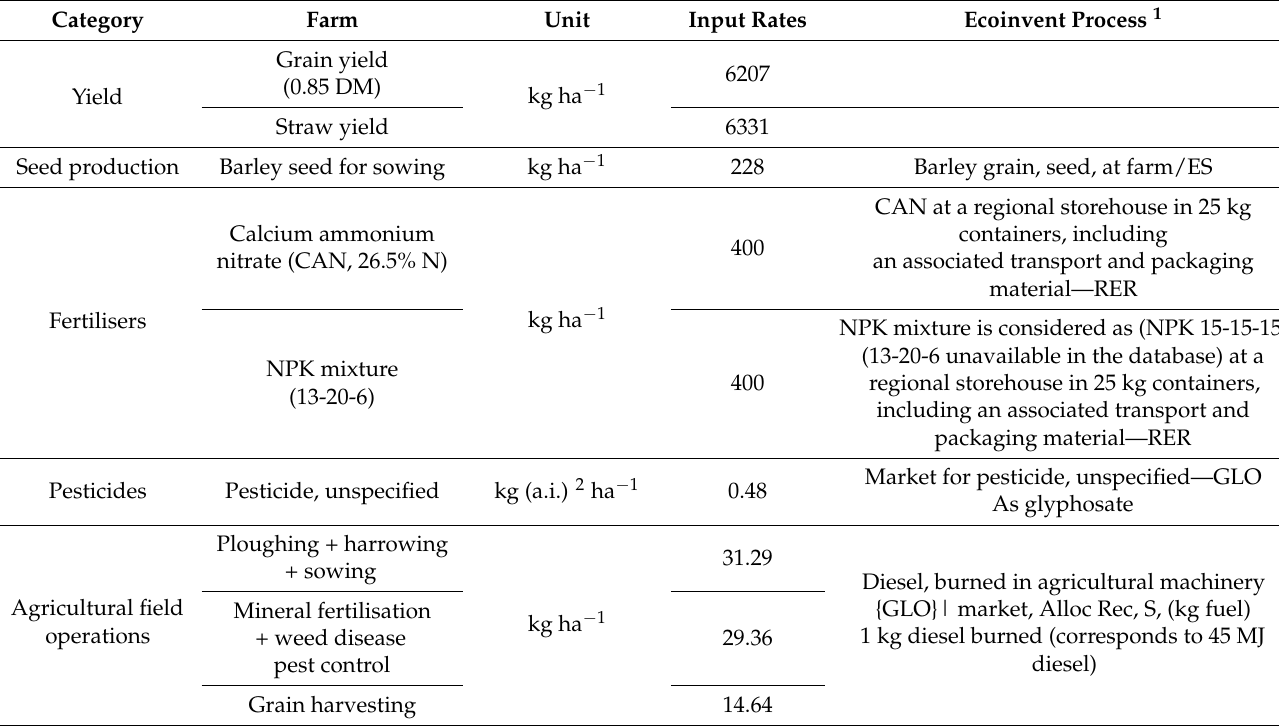
Table 1. Input and output flows included in the LCI modelling. Functional unit = 1 tonne of harvested barley grain (dry mass of